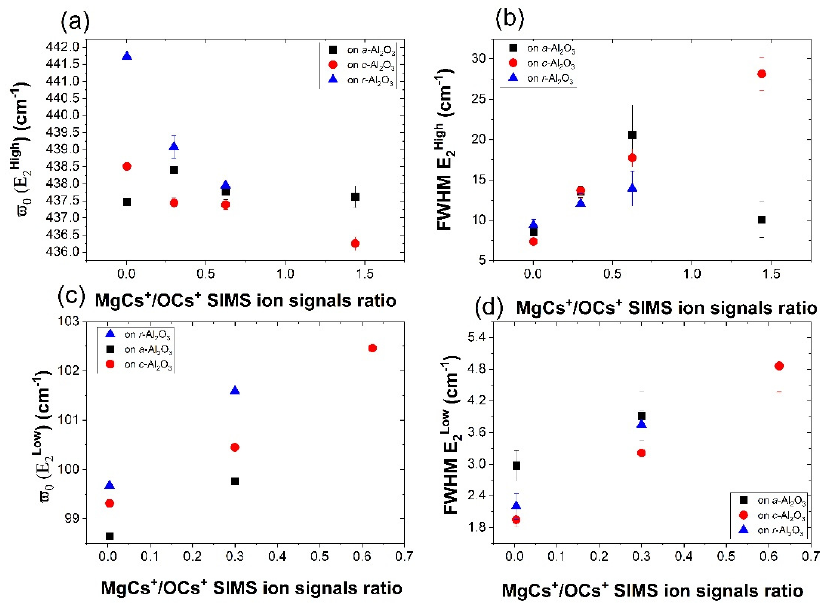
Figure 10. ( a , c ) Phonon frequency ω o and ( b , d ) with the Raman E 2 high and E 2 Low mode as functions of Mg/O content in Zn 1 − x Mg x